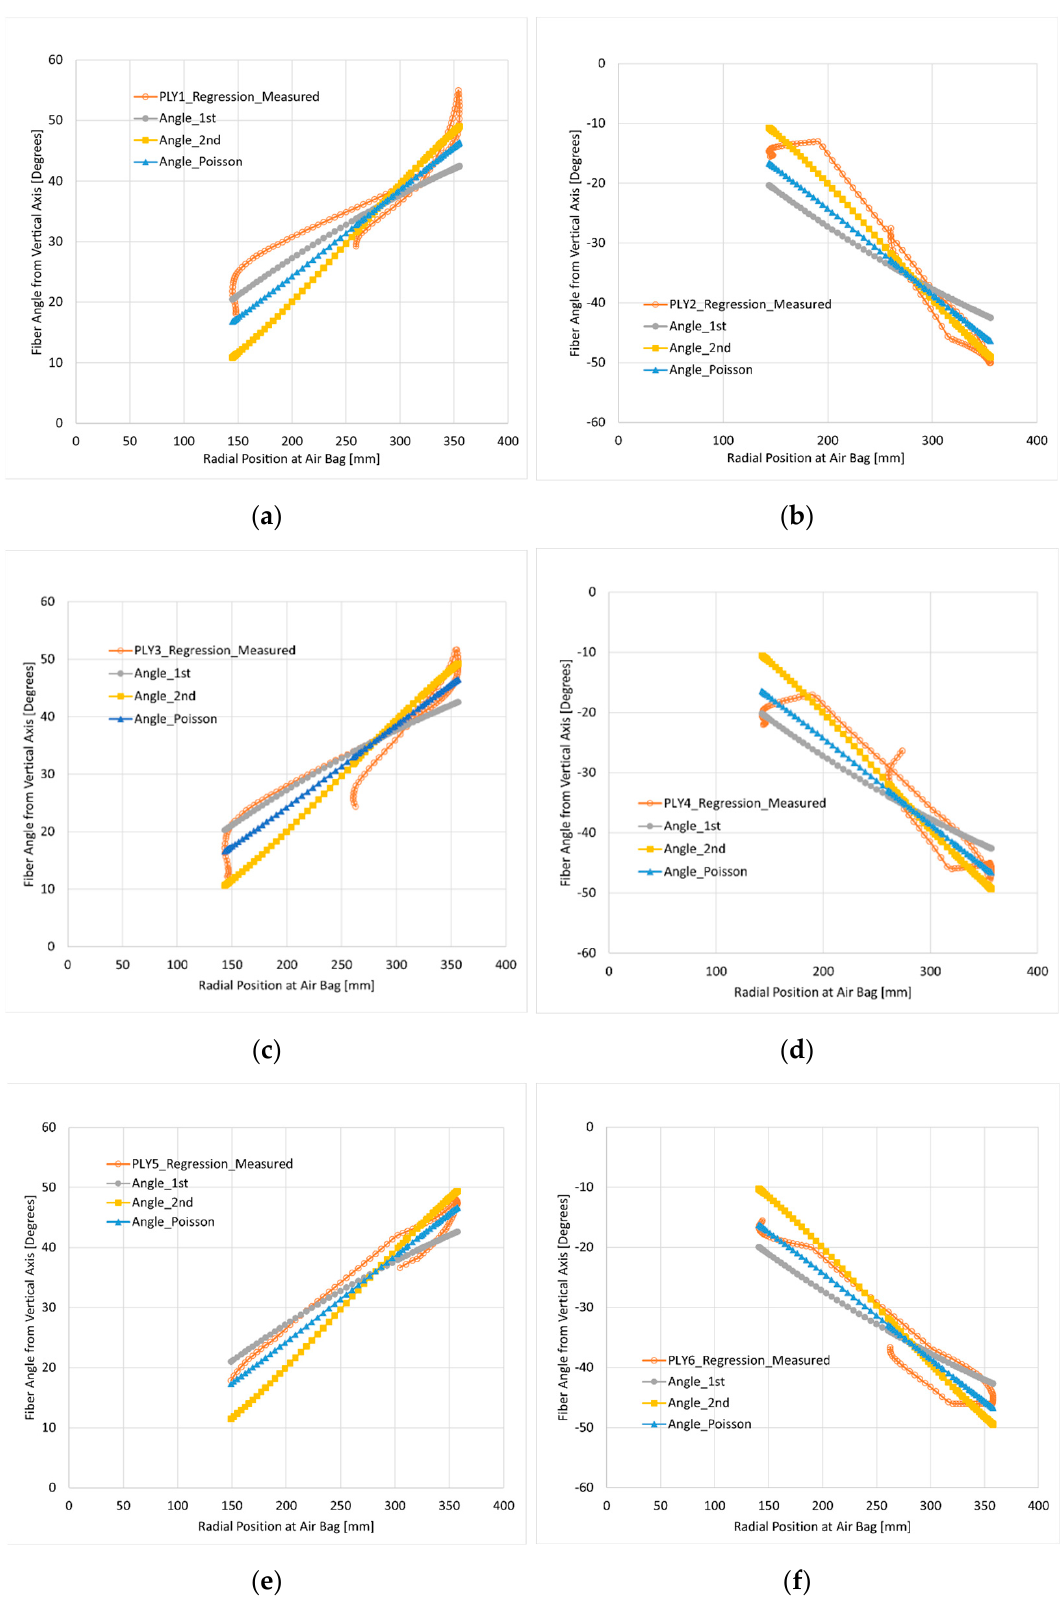
Figure 5. Comparison of ply angle measured from 684N diaphragm air spring and angle distribution using angle calculation equation: ( a ) 1st ply (inner); ( b ) 2nd ply; ( c ) 3rd ply; ( d ) 4th ply; ( e ) 5th ply; ( f ) 6th ply.